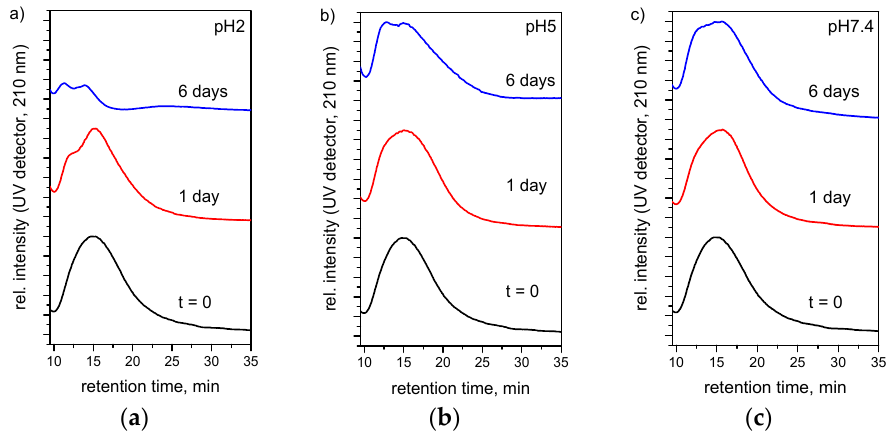
Figure 5. Normalized FFF analysis illustrating the degradation of polymer 2 at 37 °C, in an aqueous solution at pH: 2 ( a ); 5 ( b ); and 7.4 ( c ). Broadening and decrease in intensity and a shift to earlier elution time of the polymer peak are observed.